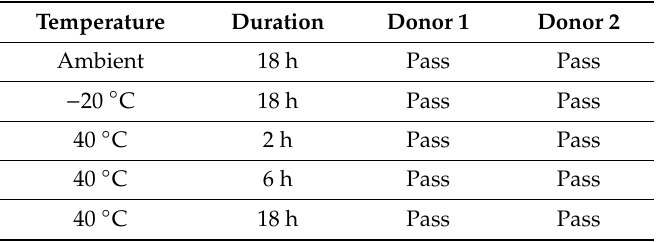
Table 1. Results from the temperature stability study for the MALDI-ToF